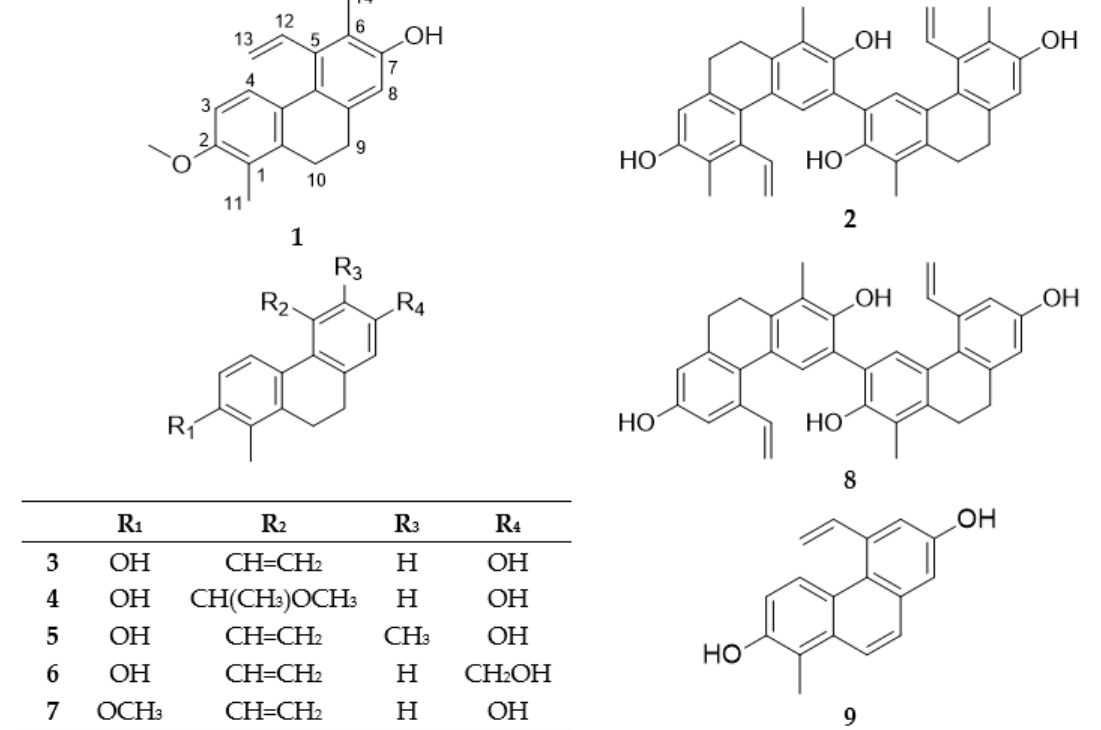
Figure 1. Structures of phenanthrenes (Compounds 1 – 9 ) isolated from J. compressus .